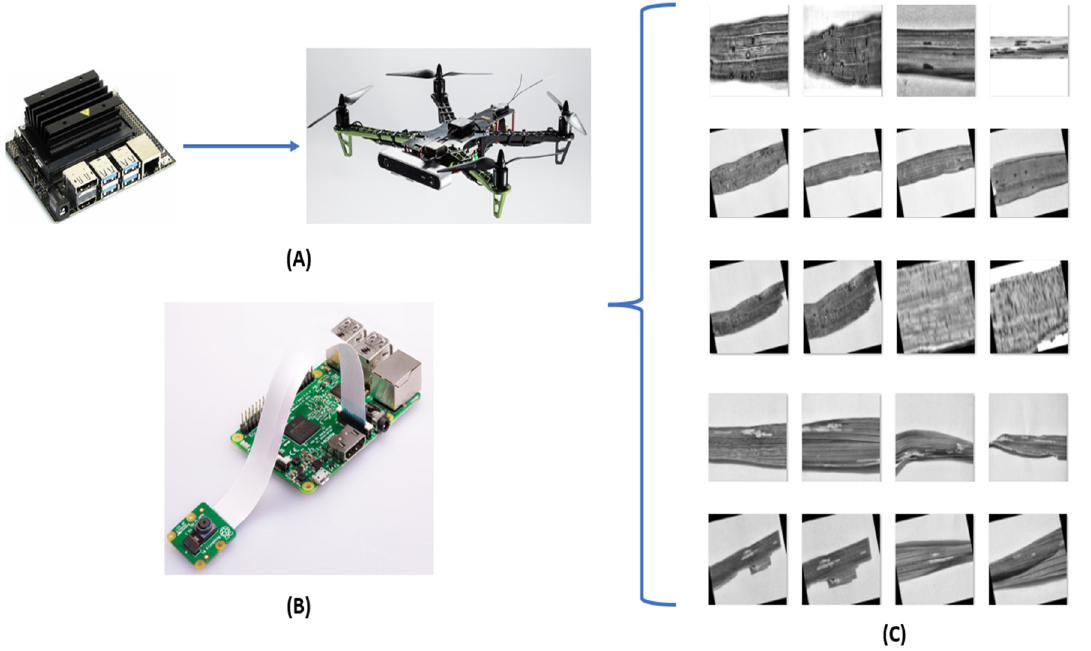
Figure 7. Fundus Procurement Process.